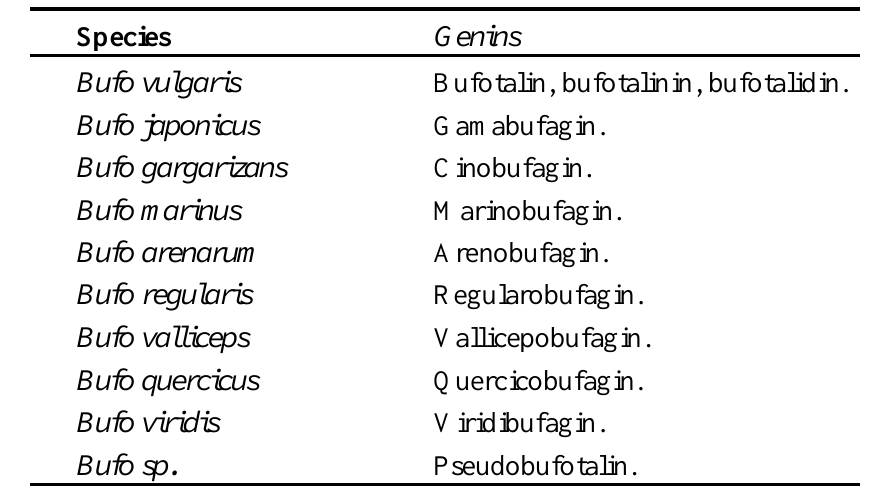
Table 2. Toad species having digitalis-like compounds.